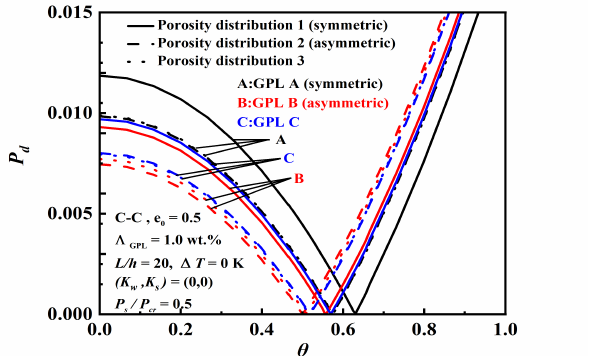
Figure 11. Effect of porosity distributions and GPL patterns on dynamic instability.